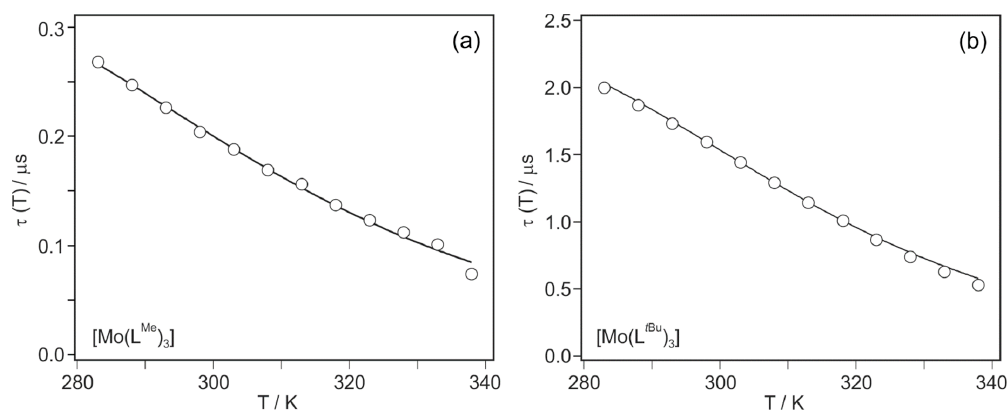
Figure 4. Temperature ‐ dependent luminescence lifetimes (circles) and fits with Equation (6) (solid lines) for ( a ) [Mo(L Me ) 3 ] and ( b ) [Mo(L t Bu ) 3 ] in toluene. See text for further details. Table 4. Results from fits with Equation (6) to the temperature ‐ dependent luminescence lifetime data in Figure 4.